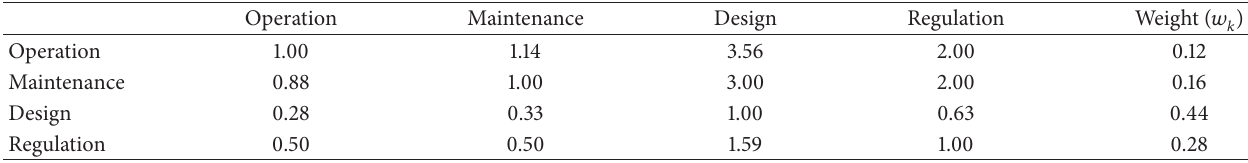
Table 5: The results of pair-wise comparison for Goal.